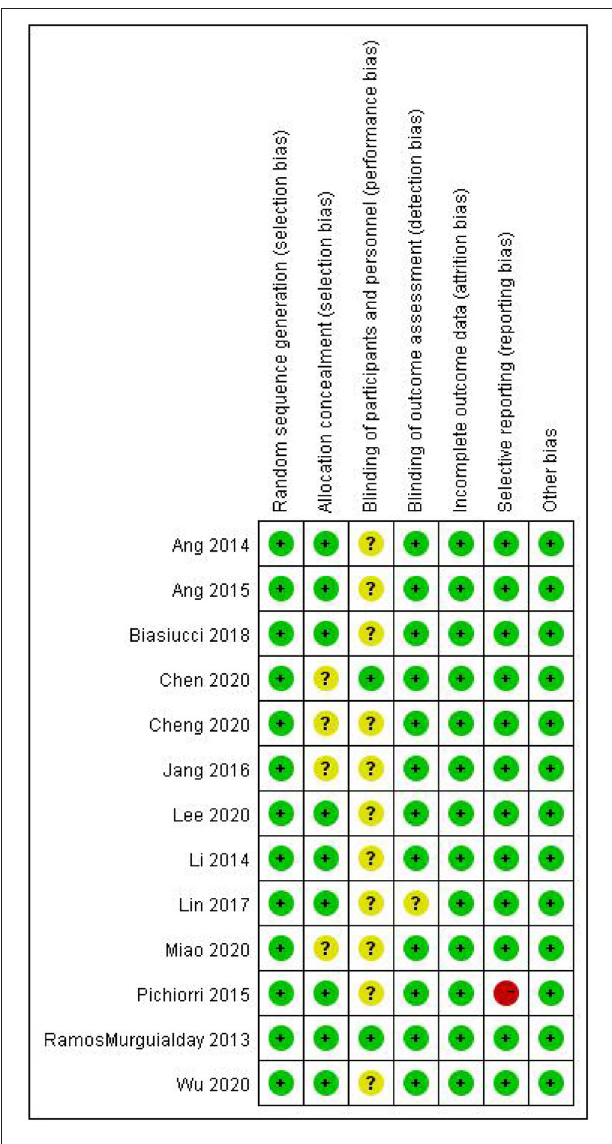
FIGURE 3 | Risk of bias